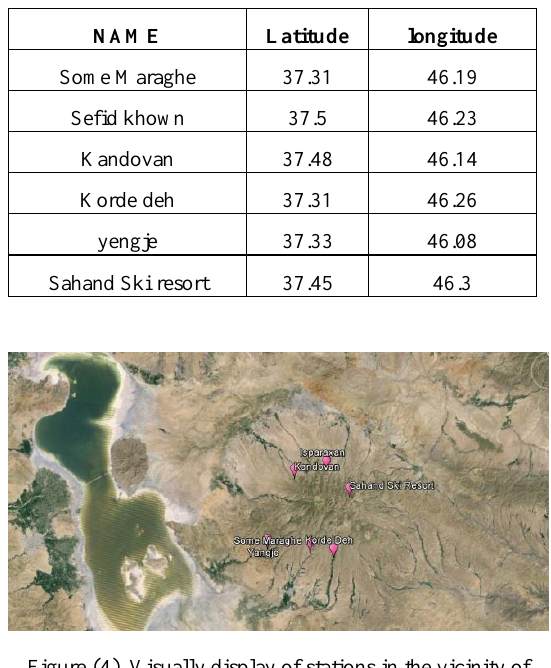
Figure (4). Visually display of stations in the vicinity of Urmia Lake